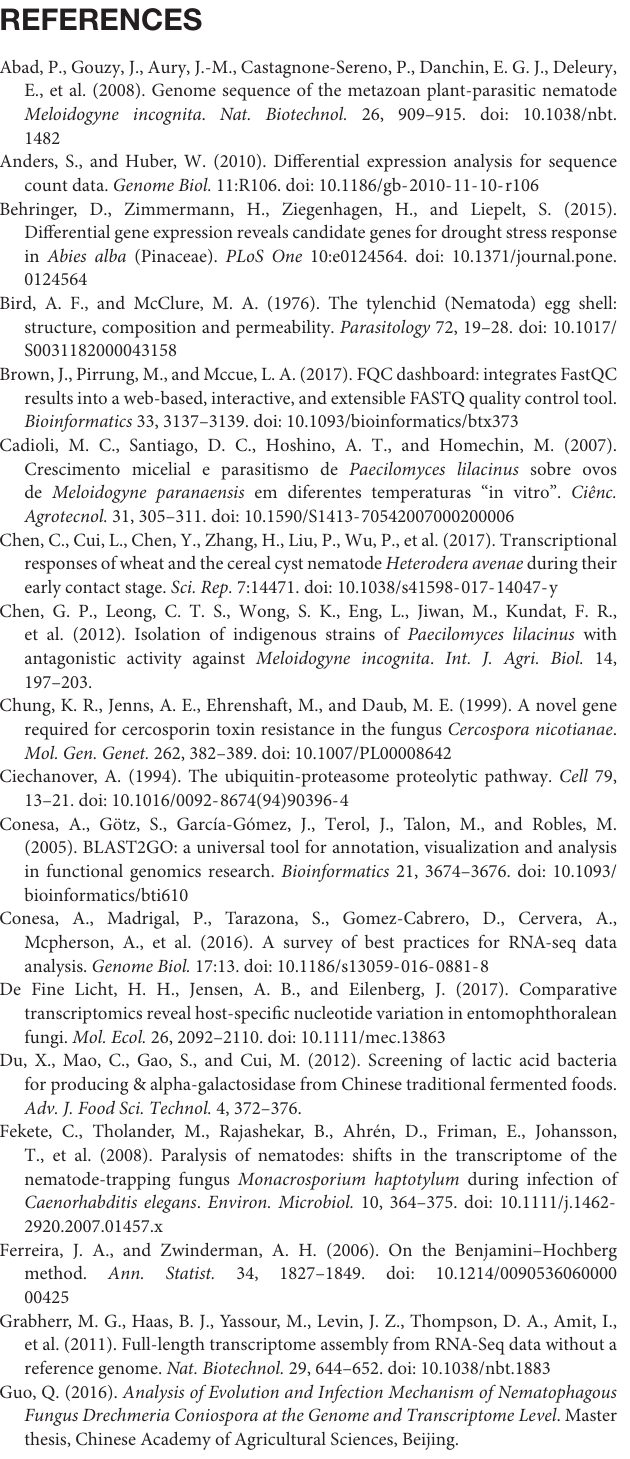
Supplementary Table 1 | Summary for infected rates of Meloidogyne incognita eggs with times post exposure to Purpureocillium lilacinum . Supplementary Table 2 | Primers used to validate sequencing data by